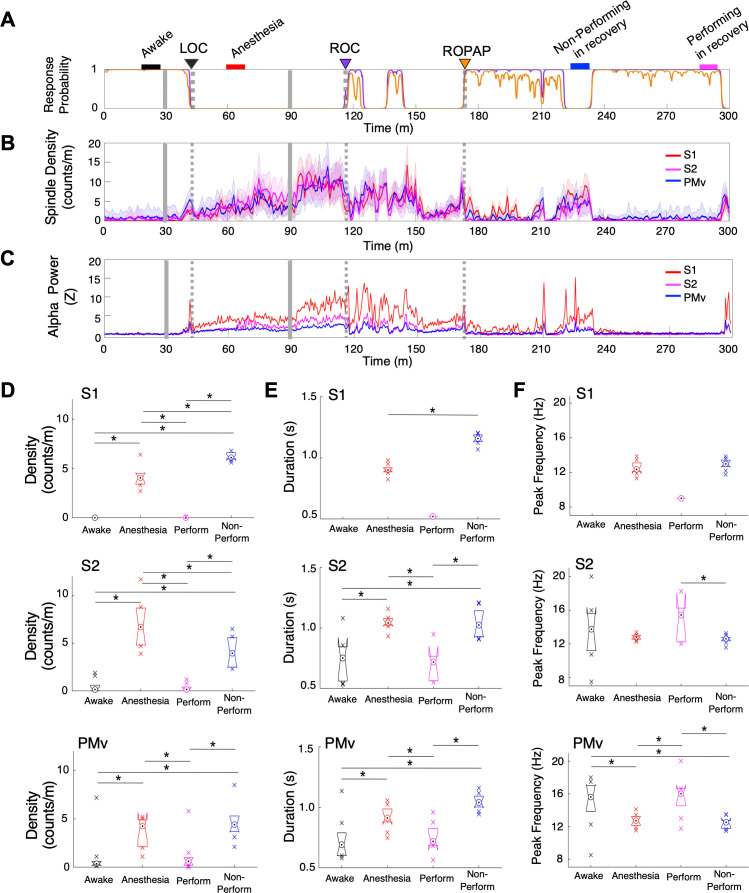
Spindle activity increases during early recovery following α2-adrenergic agonist-induced anesthesia.(A) Behavioral response. Probability of the task engagement (purple) and task performance (orange). (B) Spindle density (counts/min) in 9–17 Hz in S1 (red trace), S2 (magenta trace) and PMv (blue trace). (C) Normalized power of alpha frequency (8–12 Hz) in S1 (red trace), S2 (magenta trace) and PMv (blue trace). (D–F). Spindle characteristics in S1 (top plots), S2 (middle plots) and PMv (bottom plots) of density (D), duration (E), and peak frequency (F). Box plots represent the median with 25th and 75th percentiles and single points are all values beyond. Asterisks indicate statistically significant difference (two-sided unpaired t-test, p<0.01). Comparisons were made between the 10 min periods: awake (for the last 10 min of wakefulness before anesthesia start, black bar); anesthesia (for 10 min during anesthetic infusion, red bar); non-performing after ROPAP (for 10 min of the non-performing period, blue bar); and performing after ROPAP (for the last 10 min of the performing period, pink bar) shown in A. LOC is shown with a black arrow and dotted lines, ROC with a purple arrow and dotted lines, and ROPAP with an orange arrow and dotted lines (A–C). Dexmedetomidine was infused at 18 μg/kg/h for the first 10 min and then 4 μg/kg/h for 50 min (gray solid lines in A–C).